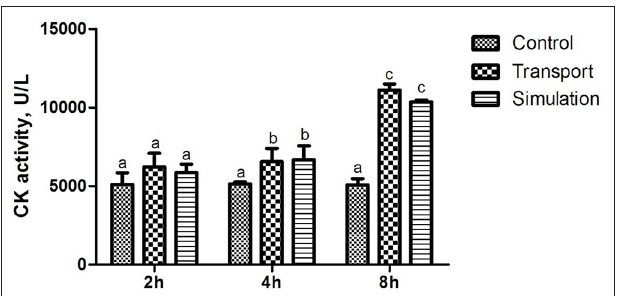
FIGURE 1 | Effects of transport stress on the cardiac performance of newborn chicks. Row (Column) with different small letter superscripts indicates a significant difference ( p < 0.05). Row (Column) with different small letter superscripts indicates no significant difference ( p > 0.05). Control, the control groups; Transport, the transport groups; Simulation, the simulation transport